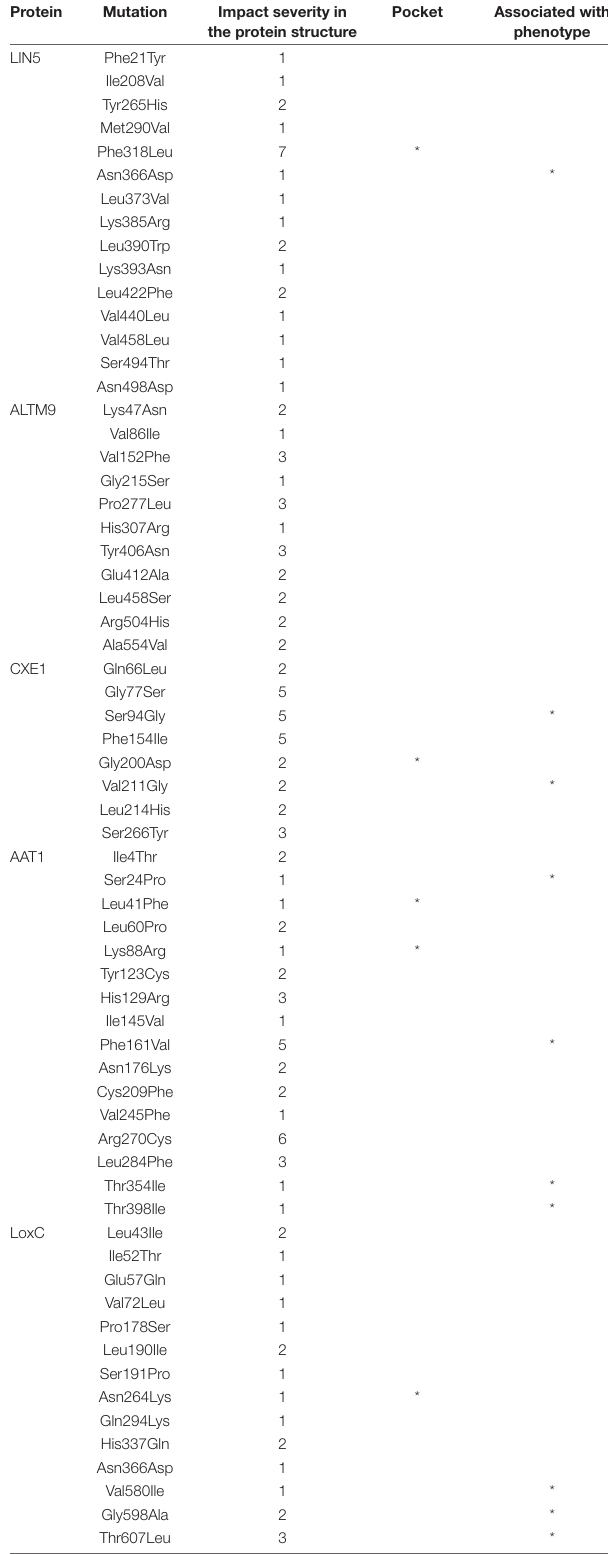
TABLE 3 | Amino acid changes and predicted impact in protein structure. Protein